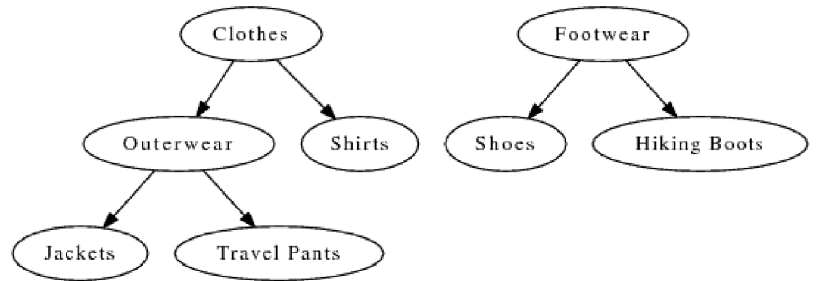
Figure 1. Example hierarchy. doi:10.1371/journal.pone.0084475.g001 PLOS ONE |